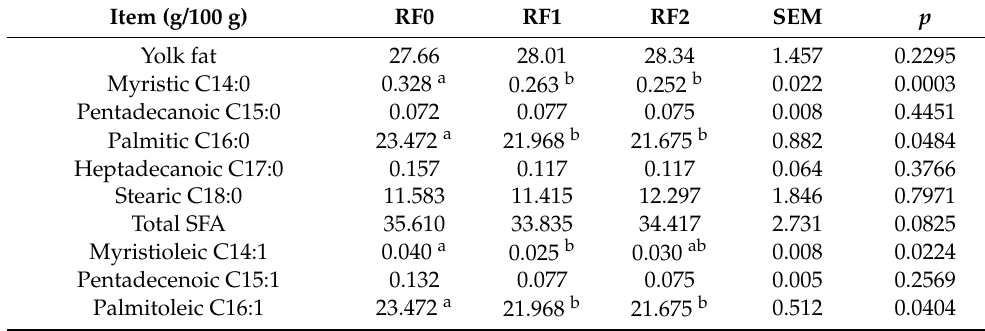
Table 6. Effect of rosehip and flaxseed meal on egg yolk fat and the fatty acid in fresh egg yolks. Item (g/100